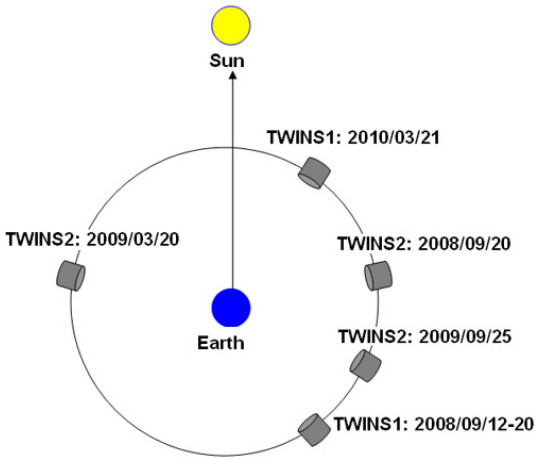
Fig. 3. Spacecraft positions: The TWINS1/2-apogee positions (grey cylinders) included in the equinox dataset, which was combined from TWINS1/2 measurements of different solar spring- and fall- equinox constellations between 2008 and 2010.